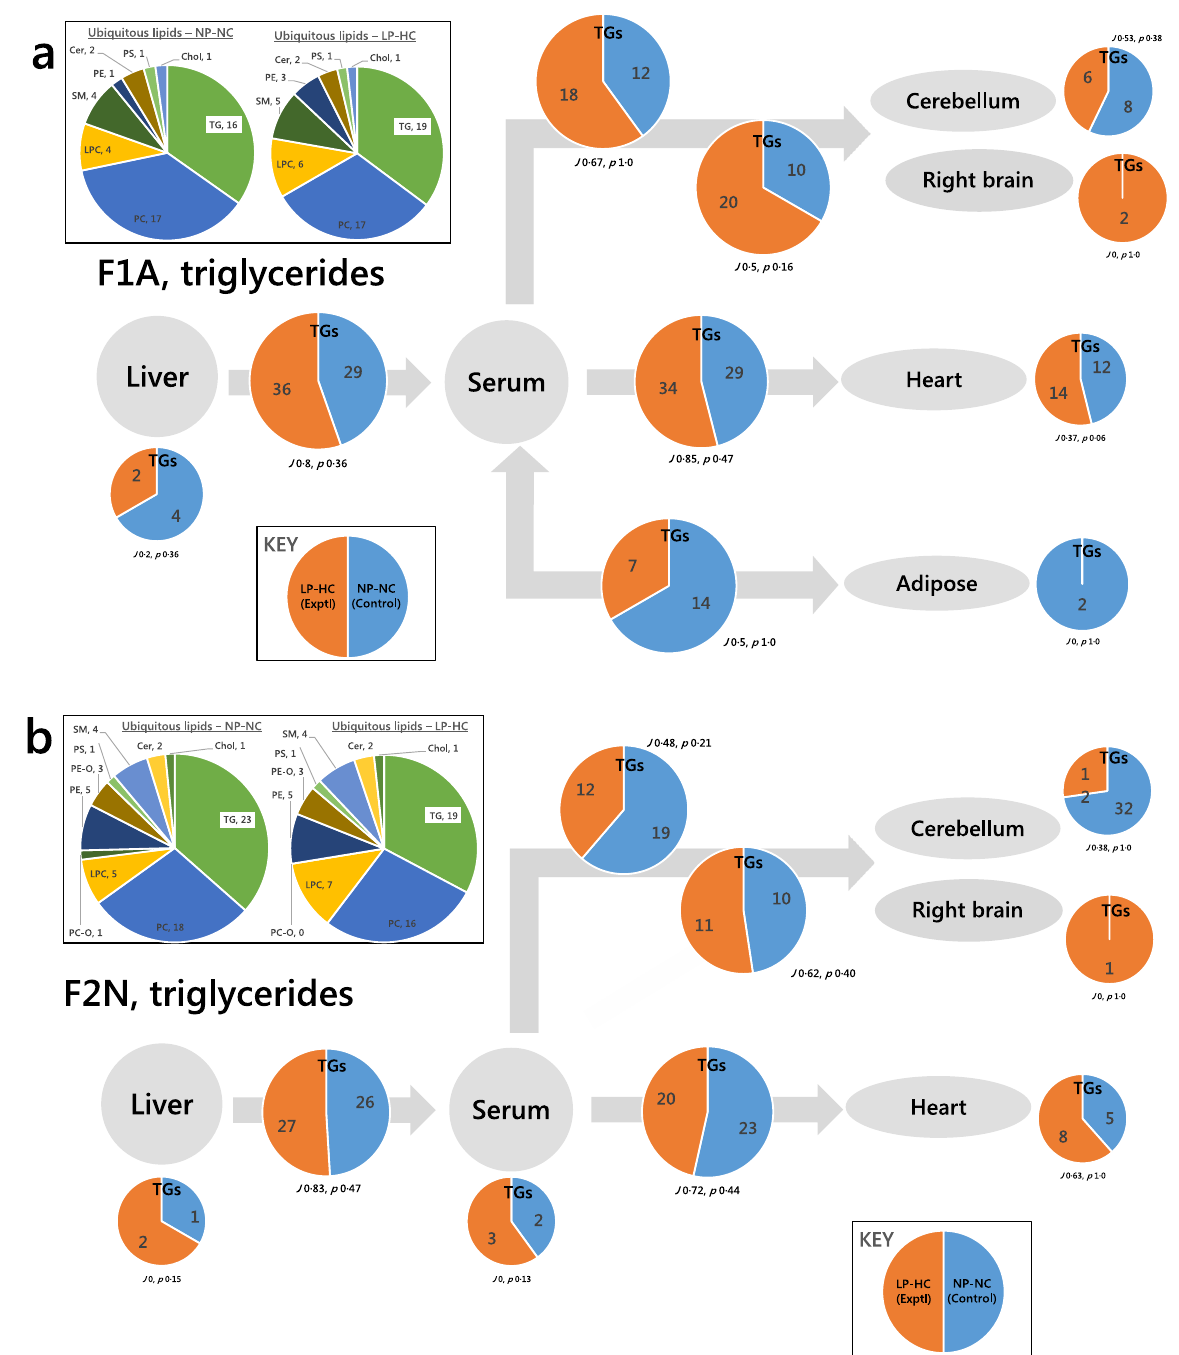
Fig. 4 Switch Analyses of triglyceride variables in the adult F1 (F1A) and neonatal F2 (F2N) offspring of fathers fed a normal (NP-NC) or a low-protein, high carbohydrate (LP-HC) diet, measured by mass spectrometry in positive ionisation mode. a F1 Adults (F1A); b F2 Neonates (F2N). The pie charts in the insert show the number of ubiquitous lipid variables for that network, for each phenotype. Larger pie charts represent triglyceride variables found in two adjacent compartments ( B -type lipids). Smaller pie charts represent triglyceride variables found in isolated in compartments ( U -type lipids). J represents the Jaccard-Tanimoto coef fi cient for the comparison, with accompanying p value, as a measure of the similarity between the variables identi fi ed in the two phenotypes for each comparison. The p value shown represents the probability that the difference between the lists of variables for the two phenotypes occurred by random chance. Orange is used for the LP-HC group whereas blue is used for the NP-NC group. Cer, ceramide; Chol, cholesterol; DG, diglyceride (water-loss product from fragmentation in source); LPC, lyso -phosphatidylcholine; LPE, lyso -phosphatidylethanolamine; LPG lyso - phosphatidylglycerol; PA, phosphatidic acid; PC, phosphatidylcholine; PC-O, phosphatidylcholine plasmalogen; PE, phosphatidylethanolamine; PE-O, phosphatidylethanolamine plasmalogen; PG, phosphatidylglycerol; PI, phosphatidylinositol; PS, phosphatidylserine; SM, sphingomyelin; TG,